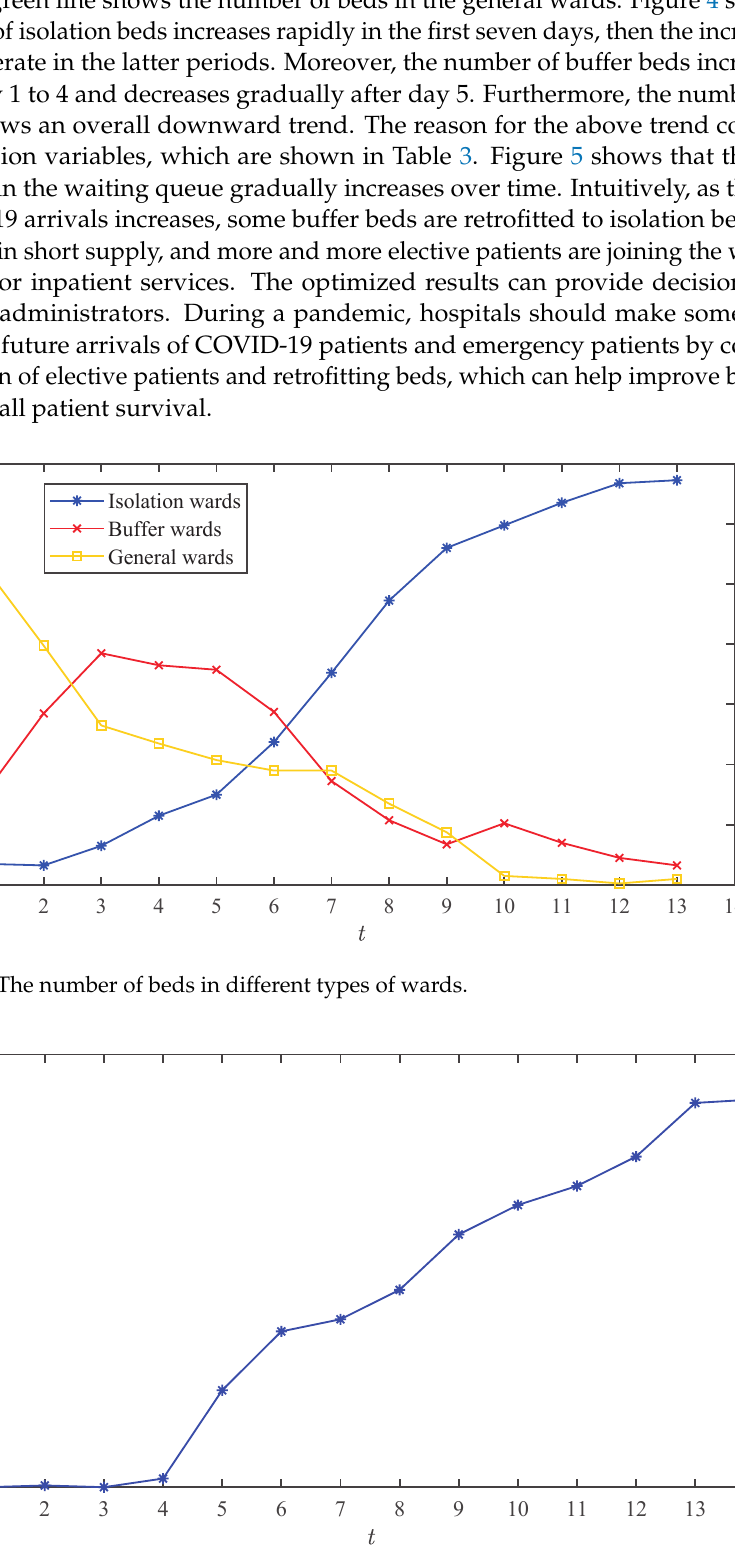
Figure 5. The number of patients in the waiting queue in base